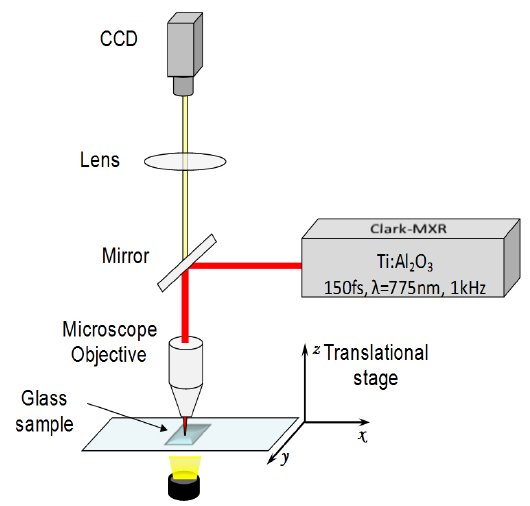
Figure 1. Schematic diagram of the experimental setup used for fs-laser micromachining in